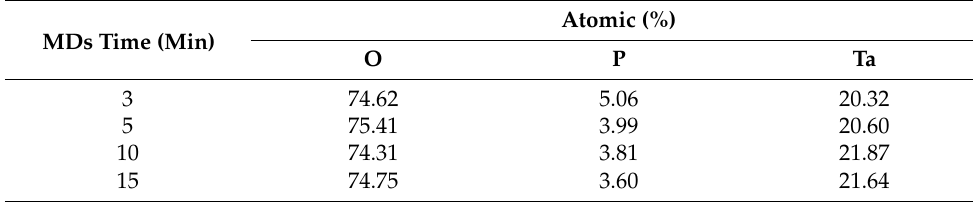
Table 1. EDS elemental analysis of coatings in Figure 4a.